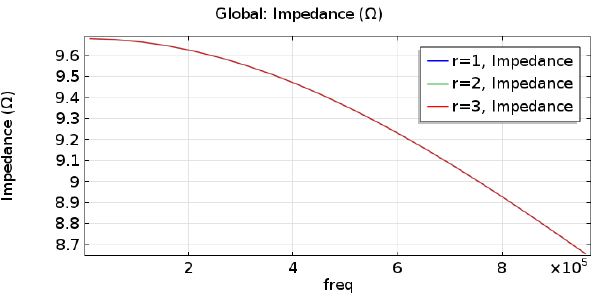
Fig. 6: The magnitude of impedance of all layers versus the range of frequencies with and without the pulse.